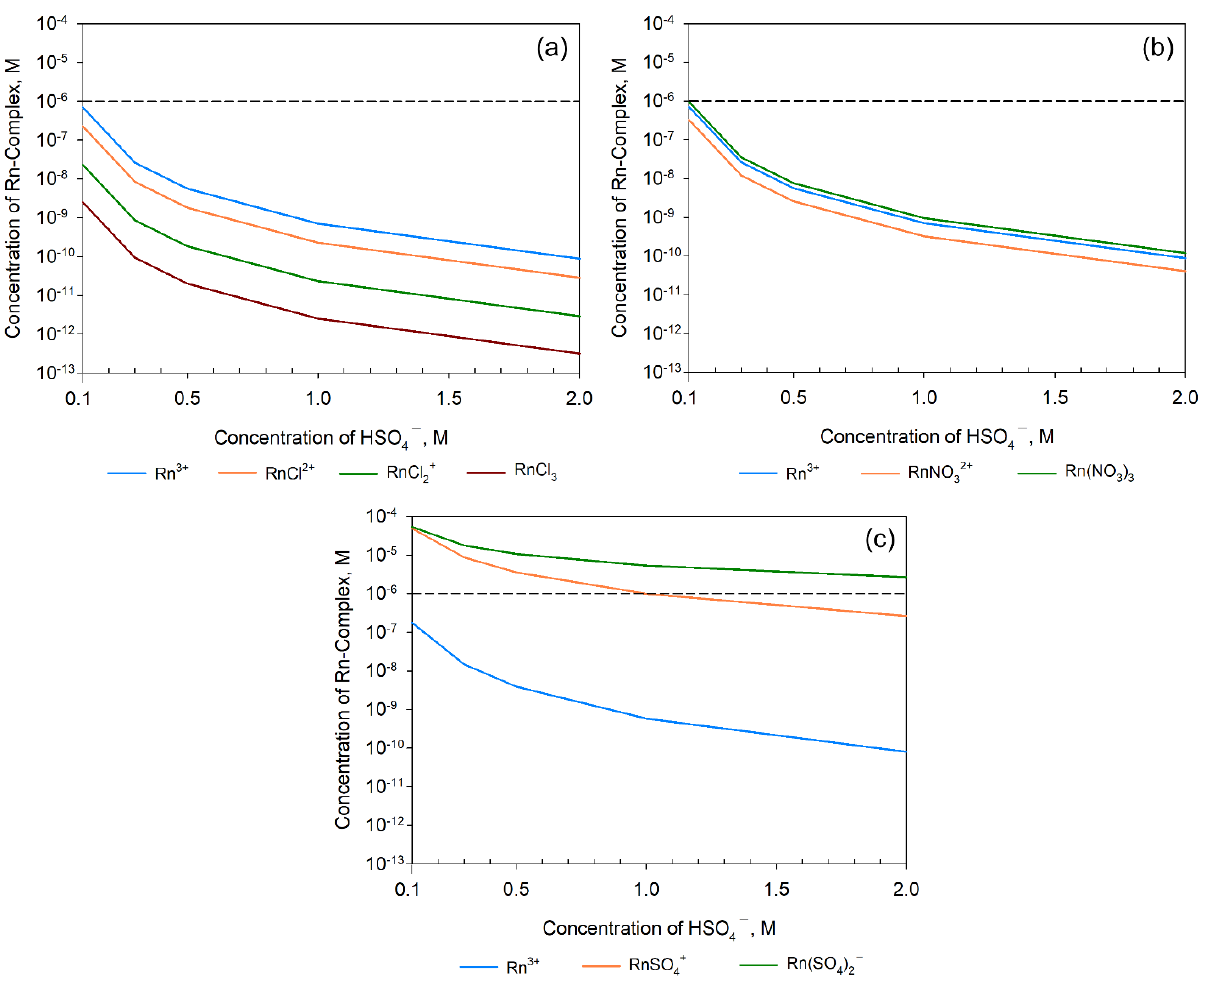
Figure 11. Equilibrium concentration of REE complexes with Na double salt at pH 1 in ( a ) HCl; ( b ) HNO 3; and ( c ) H 2 SO 4 systems (dashed line: 1 ppm line).